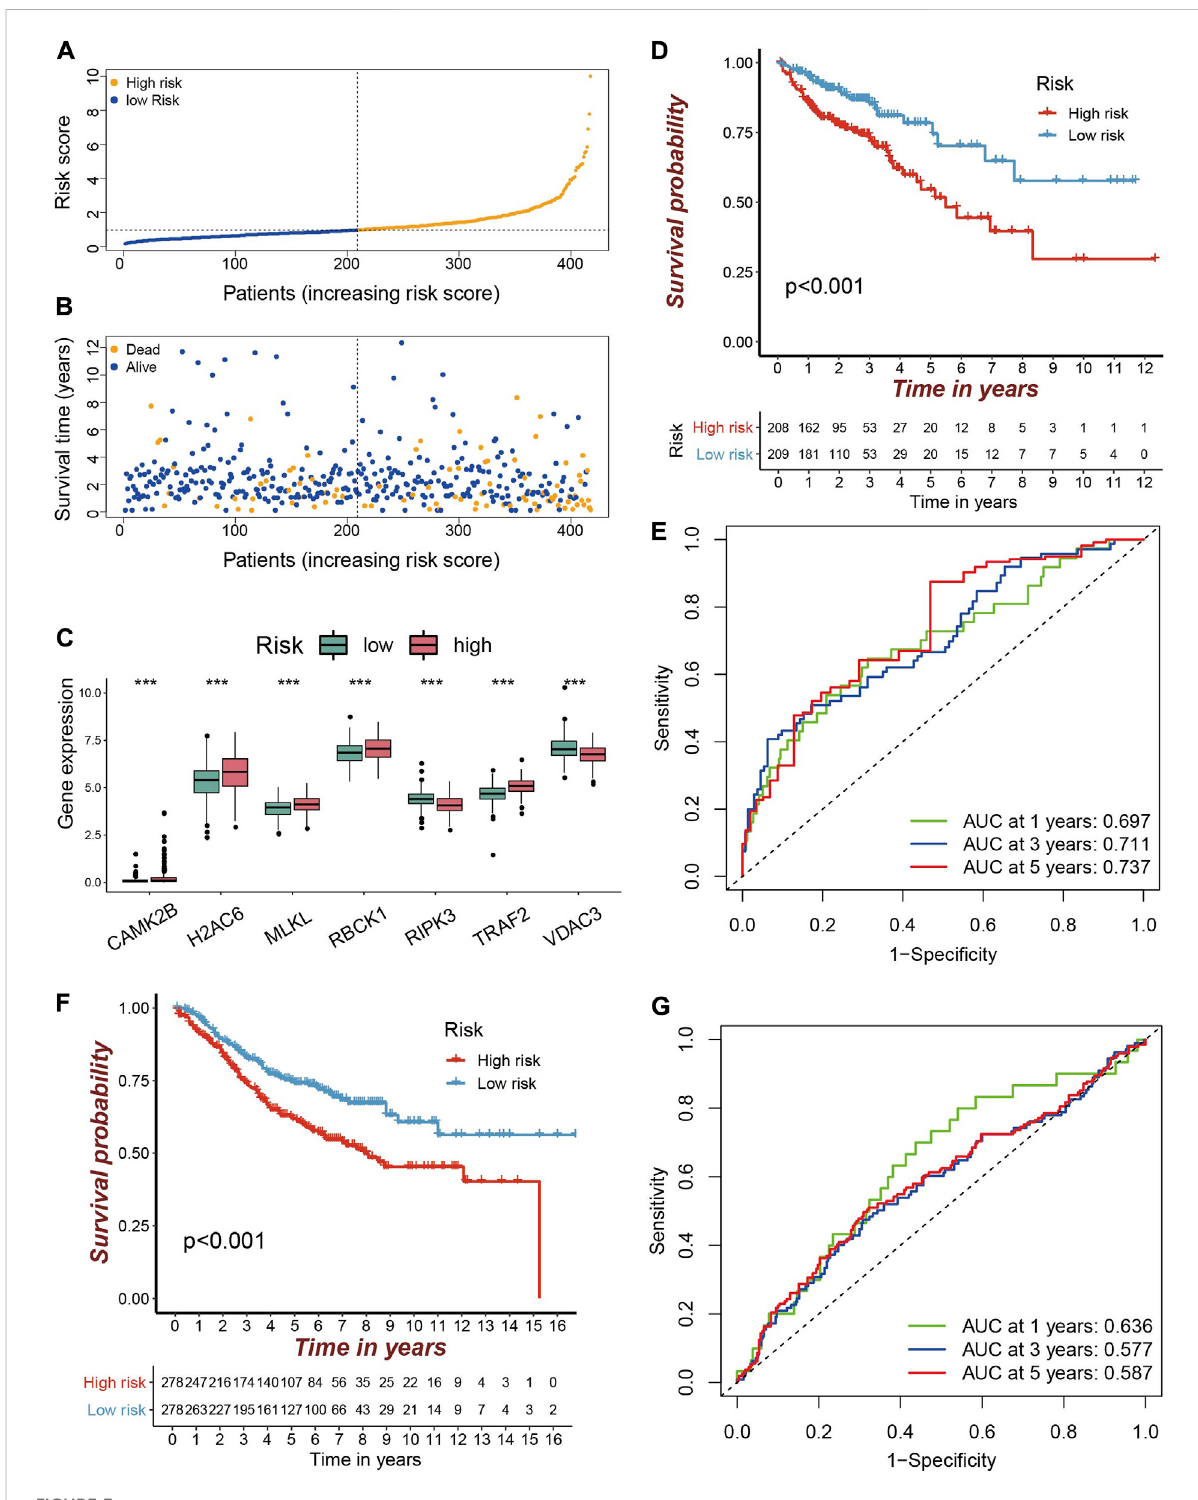
FIGURE 3 Validation of the prognostic NRGs signature in COAD patients (A – B) The TCGA-COAD samples were divided into high and low risk groups accordingtothemedianriskscore.Thelargertheriskscore,themorethesamplesofdeaths. (C) Differentiallyexpressionofprognosticgenesinhigh and low risk groups are depicted in a boxplot. Red is the high risk group and green is the low risk group (*** p < 0.001). (D) Kaplan-Meier curve for predicting OS intheTCGA cohort. Red isthehighrisk group andblue isthelowrisk group. (E) ROC curvein theTCGAcohort. (F) Kaplan – Meier curve for predicting OS in the GEO cohort. (G) ROC curve in the GEO